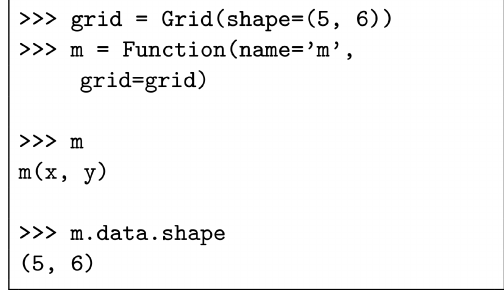
Figure 2. Defining a Devito Function on a Grid